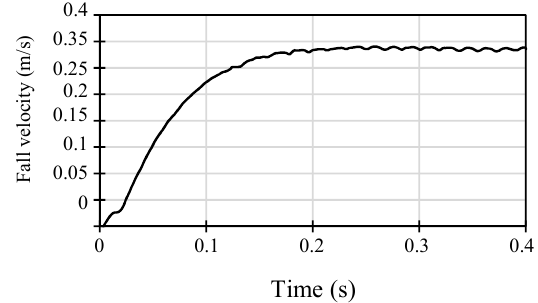
Fig. 8. Particle velocity versus time in particle with diameter of 4.36 mm